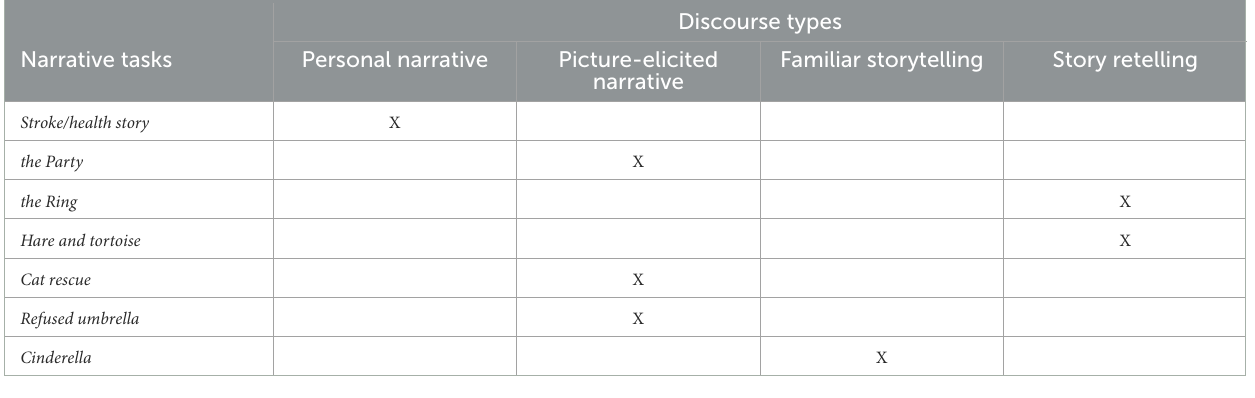
TABLE 1 Correspondence between narrative tasks and narrative discourse elicitation methods.